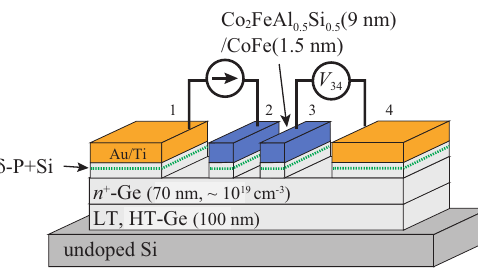
Figure 1. Schematic illustration of the fabricated lateral spin valve with ferromagnet (FM)/Ge Schottky-tunnel contacts. HT: high-temperature-grown; LT: low-temperature-grown.